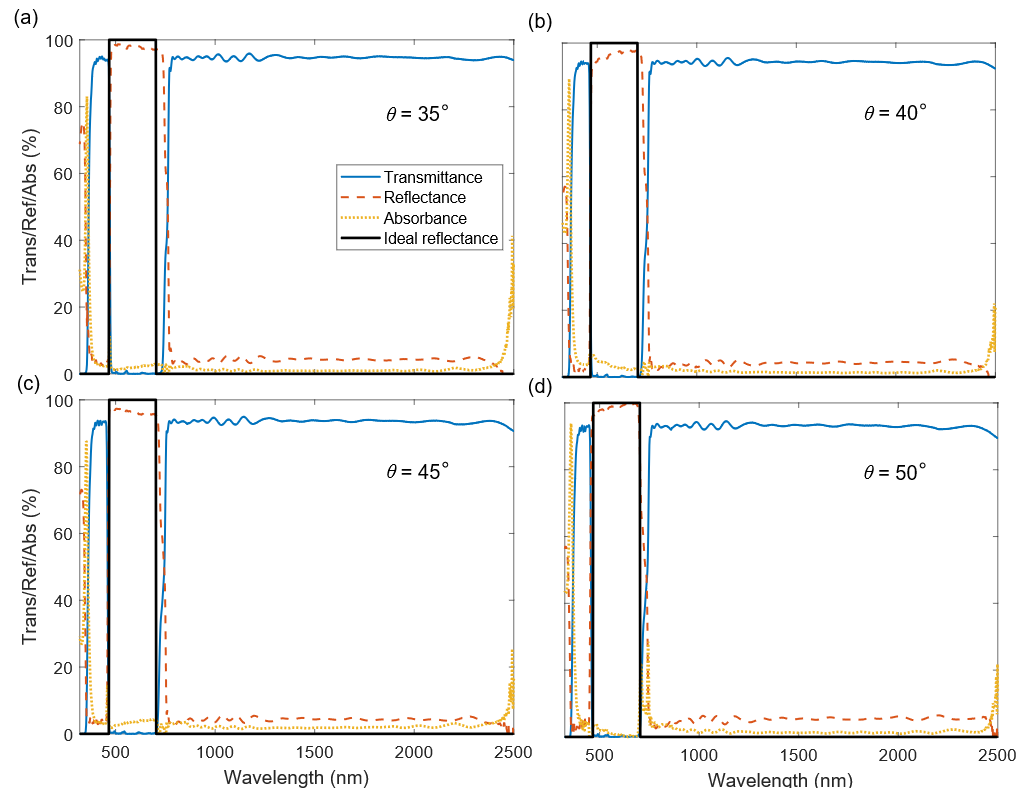
Figure 1. Measured transmittance, reflectance, and absorbance through the beam splitter at different incident light angles as denoted in each panel ( a ) θ = 35° ( b ) θ = 40° ( c ) θ = 45° ( d ) θ = 50°. For line types, refer to the legend in ( a ).